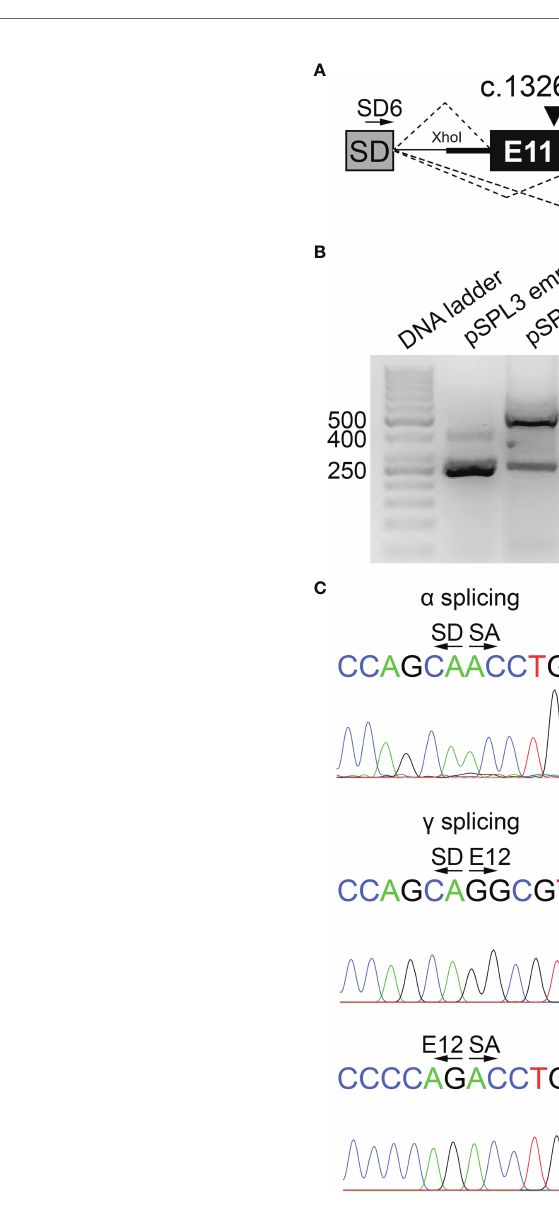
FIGURE 2 | The variant c.1326A>C causes NIS pre-mRNA splicing defect. (A) Scheme of pSPL3-based minigene reporter constructs used in functional assays. The genomic fragment containing exons 11 and 12 along with a fragment fl anking introns 10 and 12, and the spacing intron 11 was cloned between pSPL3 vector exons SD and SA using XhoI and BamHI restriction sites. Arrows show pSPL3 vector SD and SA exon-speci fi c primers (SD6 and SA2) used in RT-PCR analysis. Canonical and aberrant splicing products are indicated by dashed lines above and below the construct, respectively. The variant c.1326A>C is indicated. (B) Agarose gel electrophoresis of RT-PCR products from empty, WT or c.1326A>C pSPL3 minigene reporter transiently transfected into HeLa cells. The empty pSPL3 vector, where only SD-SA exons splicing occurred, lead to a 263 bp PCR product ( a splicing). The WT pSPL3 minigene mainly yielded a 547 bp PCR product including SD-SA exons (263 bp) fl anking the exons 11 (87 bp) and 12 (197 bp) of the SLC5A5 gene ( b splicing). The c.1326A>C pSPL3 minigene leads to a main PCR product of 263 bp including only SD-SA exons and secondary PCR products of 457 and 573 bp including SD-SA exons fl anking exon 12 alone ( g splicing) or including an arti fi cial pseudoexon derived from the intronic sequence of the reporter vector ( Supplementary Figure 1 ), respectively. Schemes represent the a , b and g splicing RT-PCR products. (C) Sequencing analysis con fi rmed the identity of a , b and g splicing RT-PCR